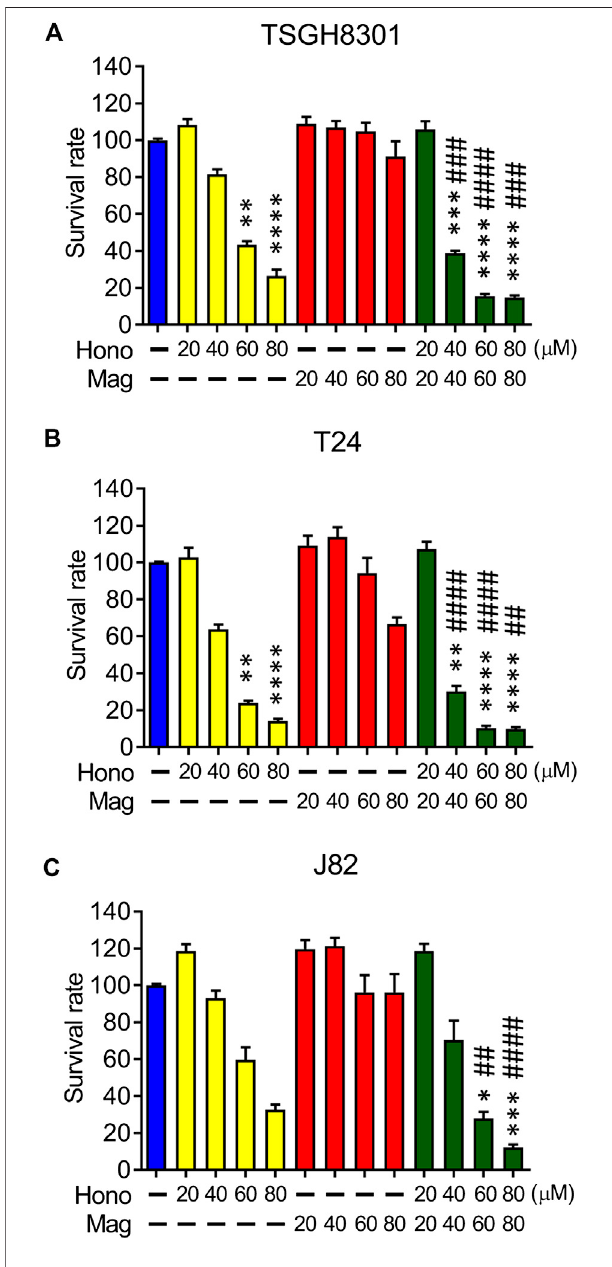
FIGURE 1 | The effects of Hono, Mag, and Hono-Mag combination treatmentoncellviability. (A) TSGH8301, (B) T24,and (C) J82bladdercancer cells were treated with DMSO or 20, 40, 60, or 80 μ M Hono, Mag, or Hono/ Mag in combination for 24 h. After treatment, the survival rates were analyzed using MTT assays. * p < 0.05; ** p < 0.01; *** p < 0.001 compared to the control group. # p < 0.05; ## p < 0.01; ### p < 0.001 compared to the group treated with the same concentration of